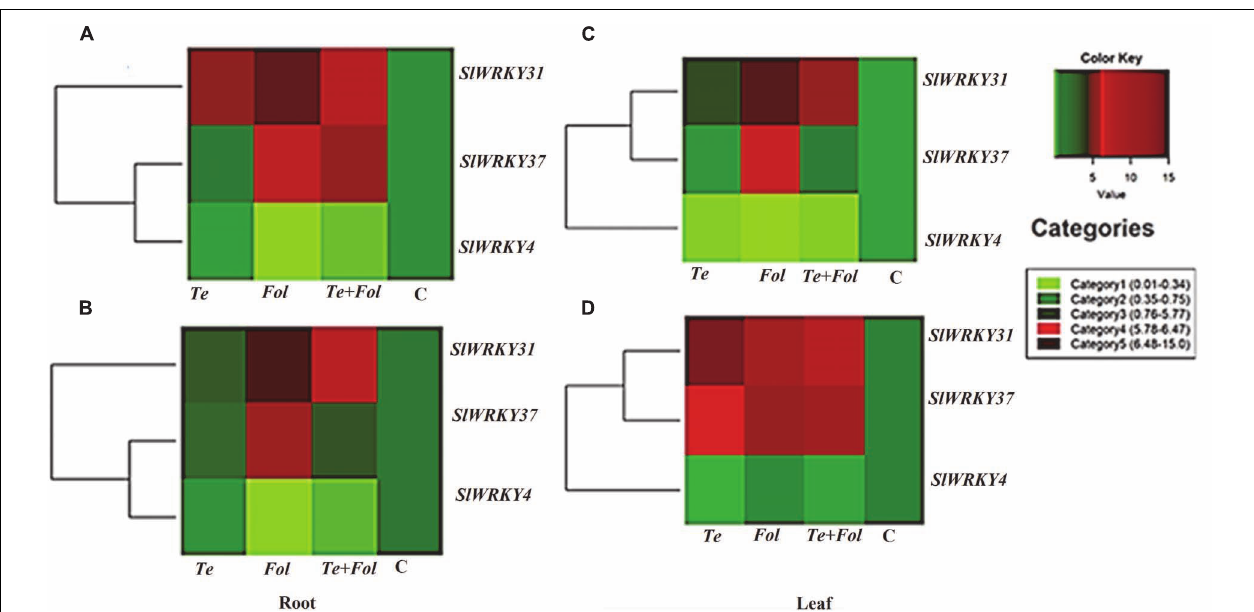
FIGURE 7 | Heat map and clustering analysis of tomato WRKY genes expressed under the four different treatment conditions. The figure includes a “heat map” which is the part of the figure having different colors (red, green, and maroon) along with dendrogram. The rows represent genes while the treatments are shown as columns. The row dendrogram represents the gene clusters with similar pattern. The expression levels are mapped on the color scale provided at the right top of the figure along with the categories scale on the right. (A) The heat map showing the expression profile changes of the SlWRKY4 , SlWRKY31 , and the SlWRKY37 genes in each of the four different treatments at 24 h in root tissues. (B) The heat map showing the expression profile changes of the SlWRKY4 , SlWRKY31 , and the SlWRKY37 genes root tissues at 48 h. (C) The heat map showing the expression profile changes of the SlWRKY4 , SlWRKY31 , and the SlWRKY37 genes in the leaf tissues at 24 h. (D) The heat map showing the expression profile changes of the SlWRKY4 , SlWRKY31 , and SlWRKY37 genes in the leaf tissues at 48